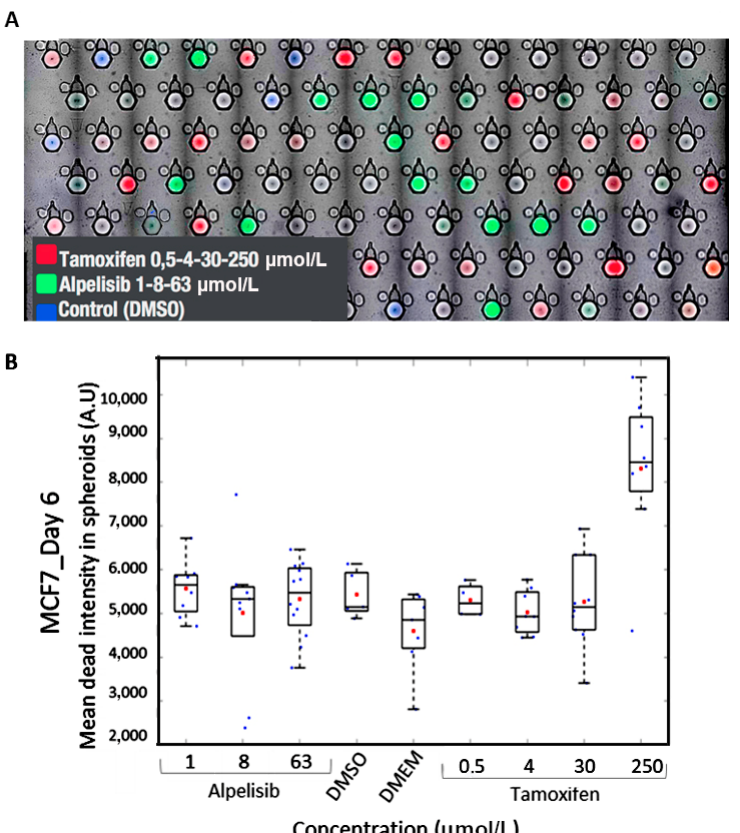
Figure 3. Treatment of MCF7 tumor cells in the microchip. A) Microscopy image of 5 merged channels: brightfield (BF, detect the trap and the spheroids), 450 nm (blue) DMSO control, 488 nm (green) alpelisib, 647 nm (red) tamoxifen, cytotoxic dye PI at 555 nm; B) cytotoxic (PI) mean dead intensity resulting from different dilution of alpelisib and tamoxifen at day